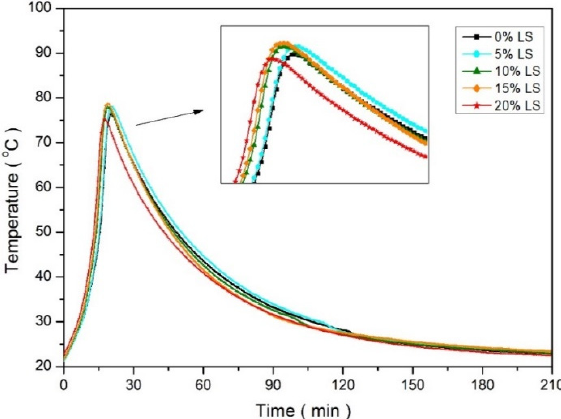
Figure 5. The evolution of hydration temperature of MAPC mortar samples with different contents of limestone fines (0–20% by weight of MAPC cement).